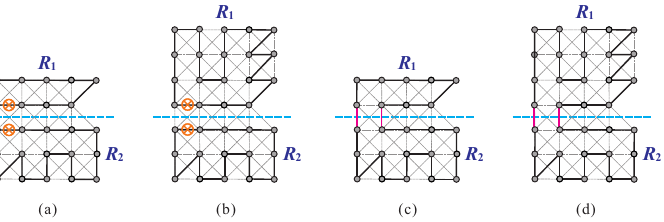
Figure 10. ( a , b ) Hamiltonian cycles in R 1 and R 2 , and ( c , d ) a Hamiltonian cycle in C ( m , n ; k , l ; c , d ) for Figure 9d,e